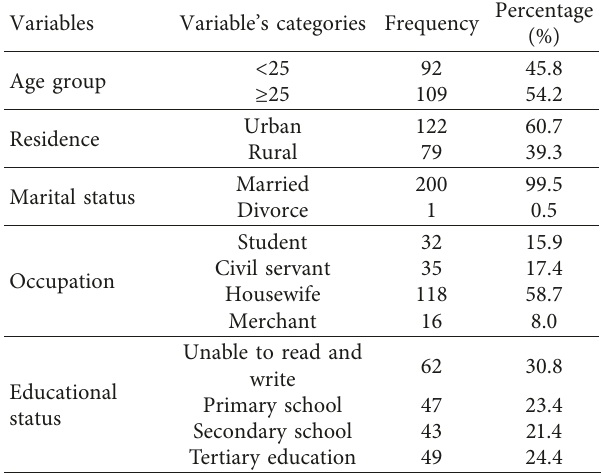
Table 1: Sociodemographic characteristics of pregnant